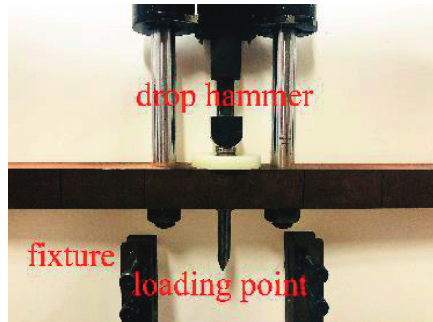
Figure 3: Impact loading device of drop hammer.